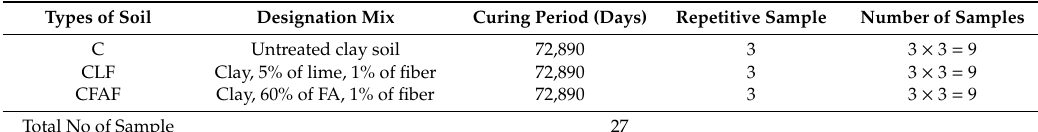
Table 4. Admixture proportions of soil